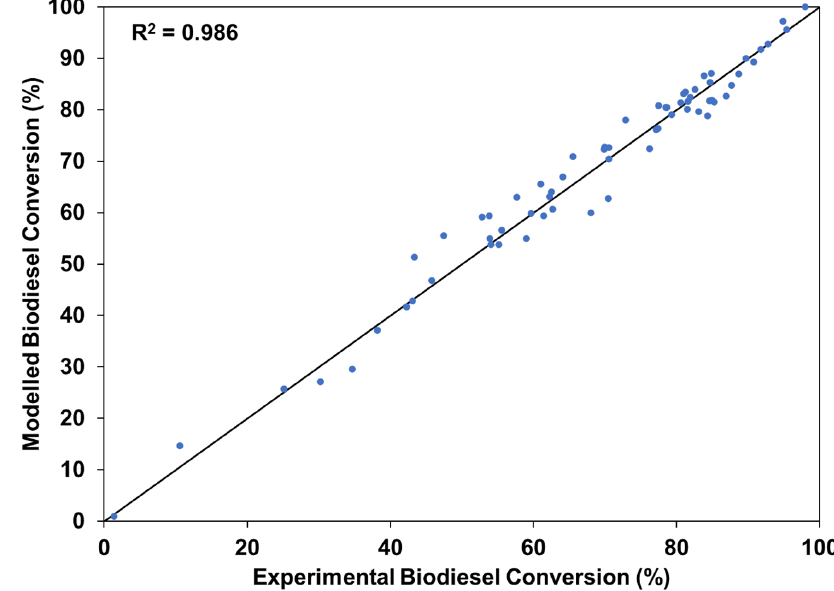
Figure 9. Parity plot for the modelled and the experimental data values for a range of biodiesel conversions studied to develop the N2IC model. Experimental data were taken from [33–36].